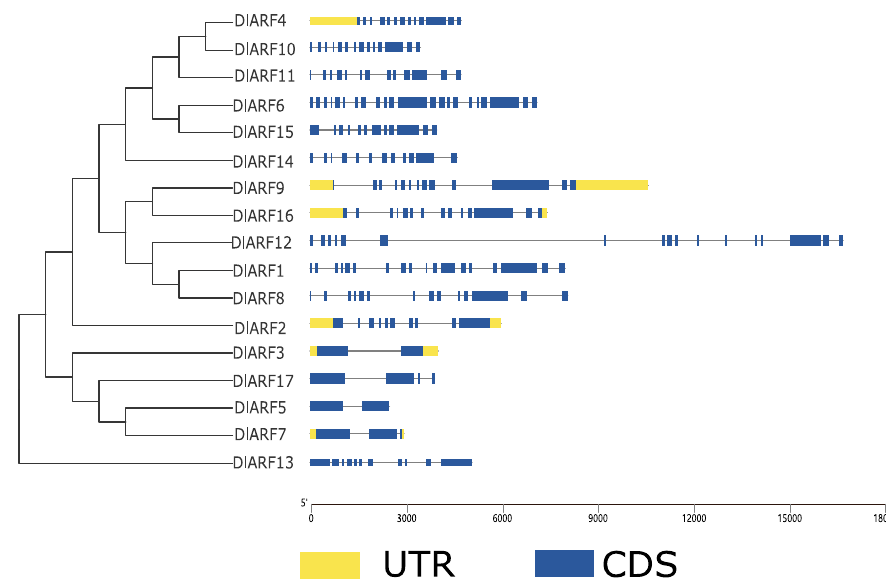
Figure 3. Gene structure analysis of DlARFs family genes. The blue boxes, yellow boxes, and the black lines indicate upstream/downstream, exons, and introns, respectively.